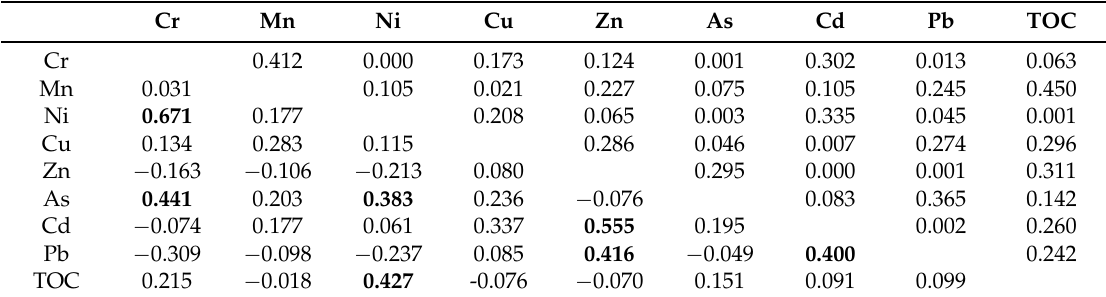
Table 3. Pearson’s correlation matrix for HM concentrations and TOC